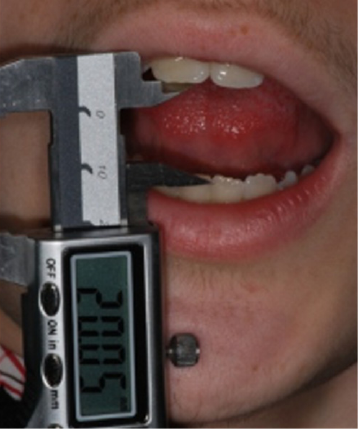
Figure 5. Mouth opening increased to 20.05 mm (age 14).